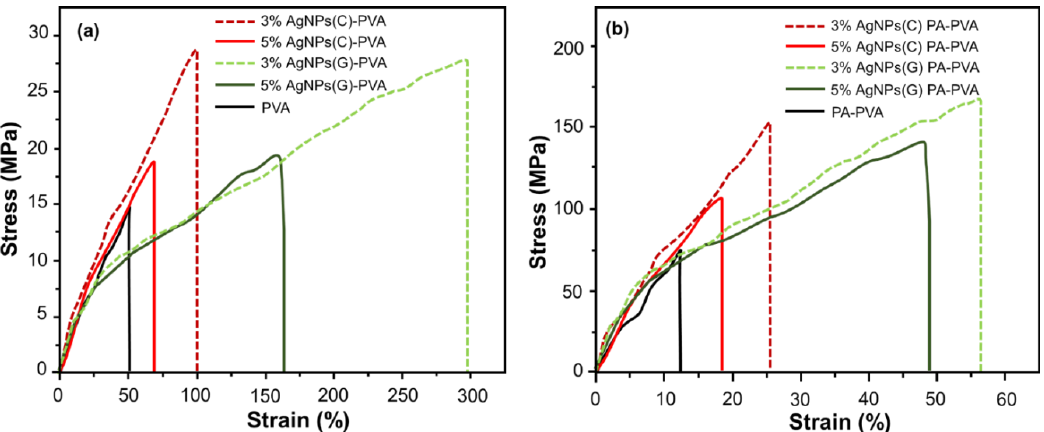
Figure 6. Stress–strain curves of: ( a ) Various Ag–NPs blended PVA films; ( b ) various Ag–NPs blended PA–PVA films.